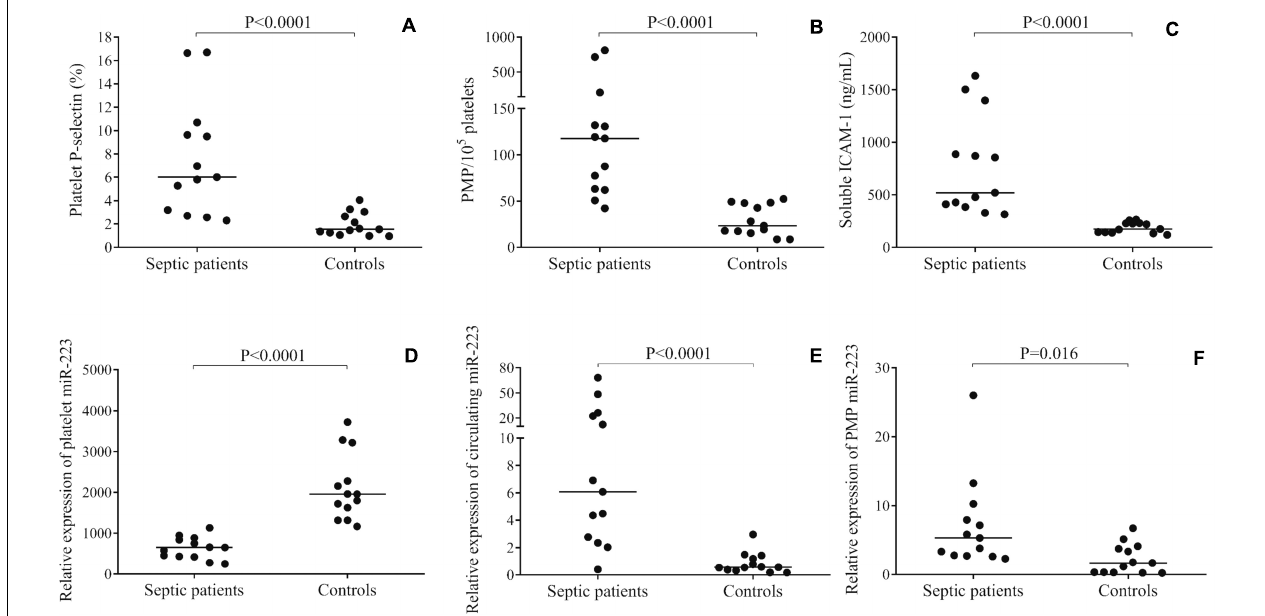
FIGURE 1 | Evaluation of the level of platelet activation in septic patients vs. controls ( n = 13/group). Surface P-selectin positivity (A) , the number of platelet-derived microparticles (PMPs) (B) and soluble intercellular adhesion molecule 1 (ICAM-1) concentration in serum samples (C) were significantly higher in sepsis vs. controls. Platelet miR-223 expression was decreased in sepsis (D) , however, plasma (E) and PMP samples (F) showed elevated miR-223 levels. Dots represent single results, and median values are depicted. Mann-Whitney U -test was performed for